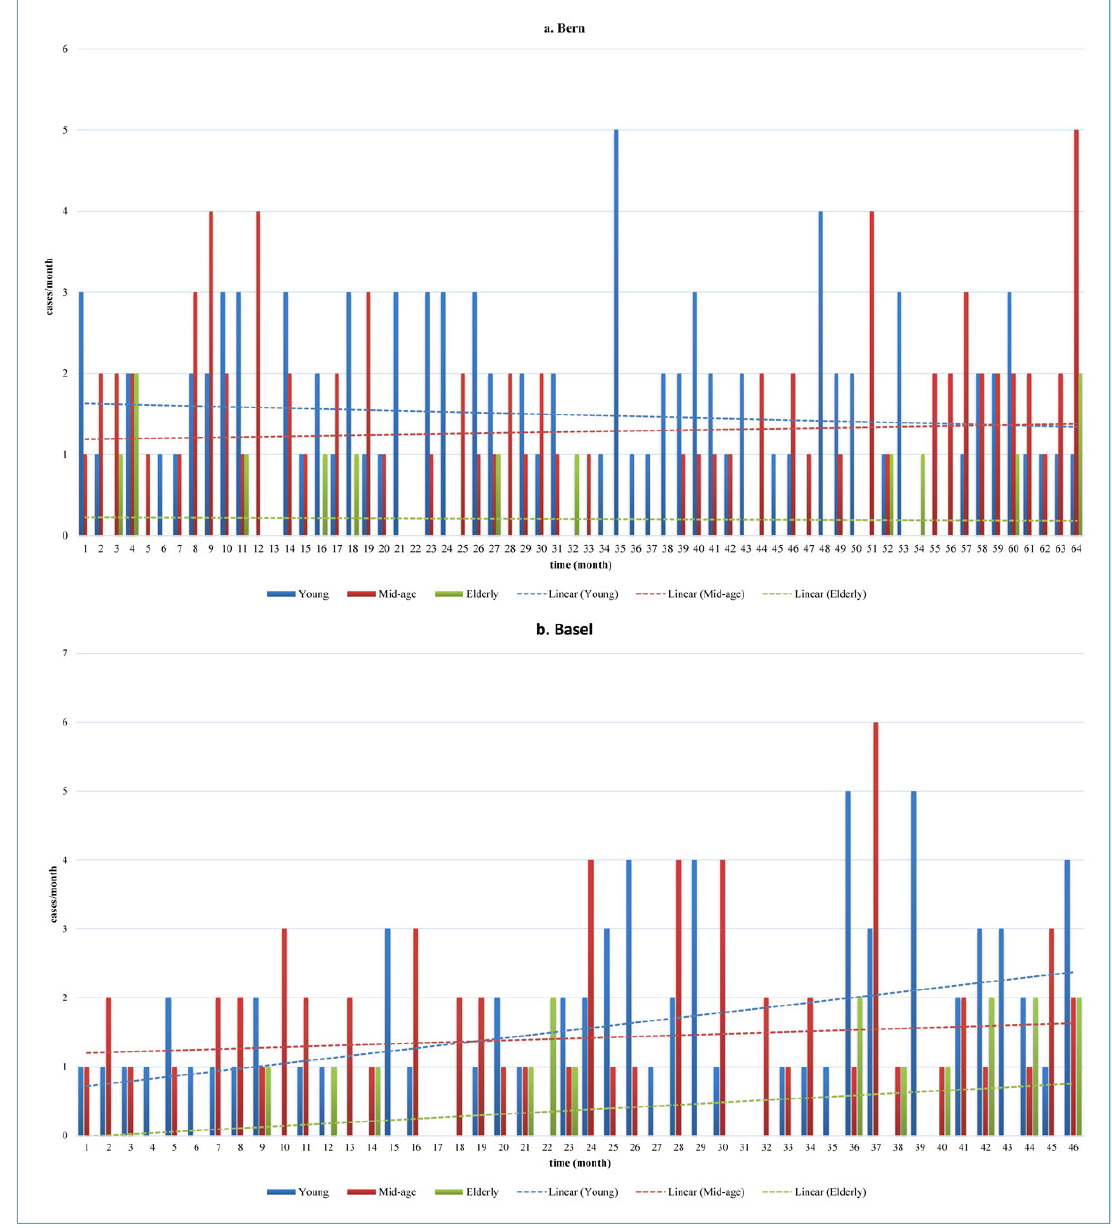
Figure 2: Time trends in the number of presentations by age group in (a) Bern, (b)